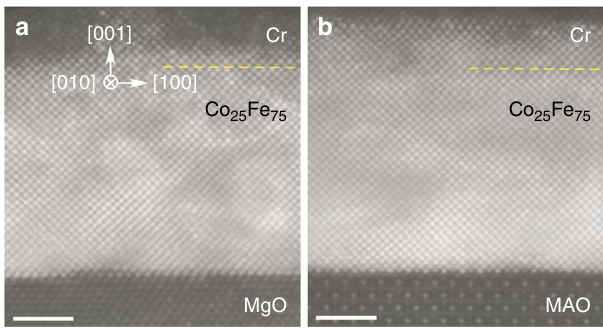
Fig. 2 Atomic resolution images of Co 25 Fe 75 fi lms. Scanning transmission electron microscopy images of a Cr(2.8 nm)/Co 25 Fe 75 (6.8 nm)/MgO and b Cr(2.8 nm)/Co 25 Fe 75 (6.8 nm)/MAO fi lms viewed along the Co 25 Fe 75